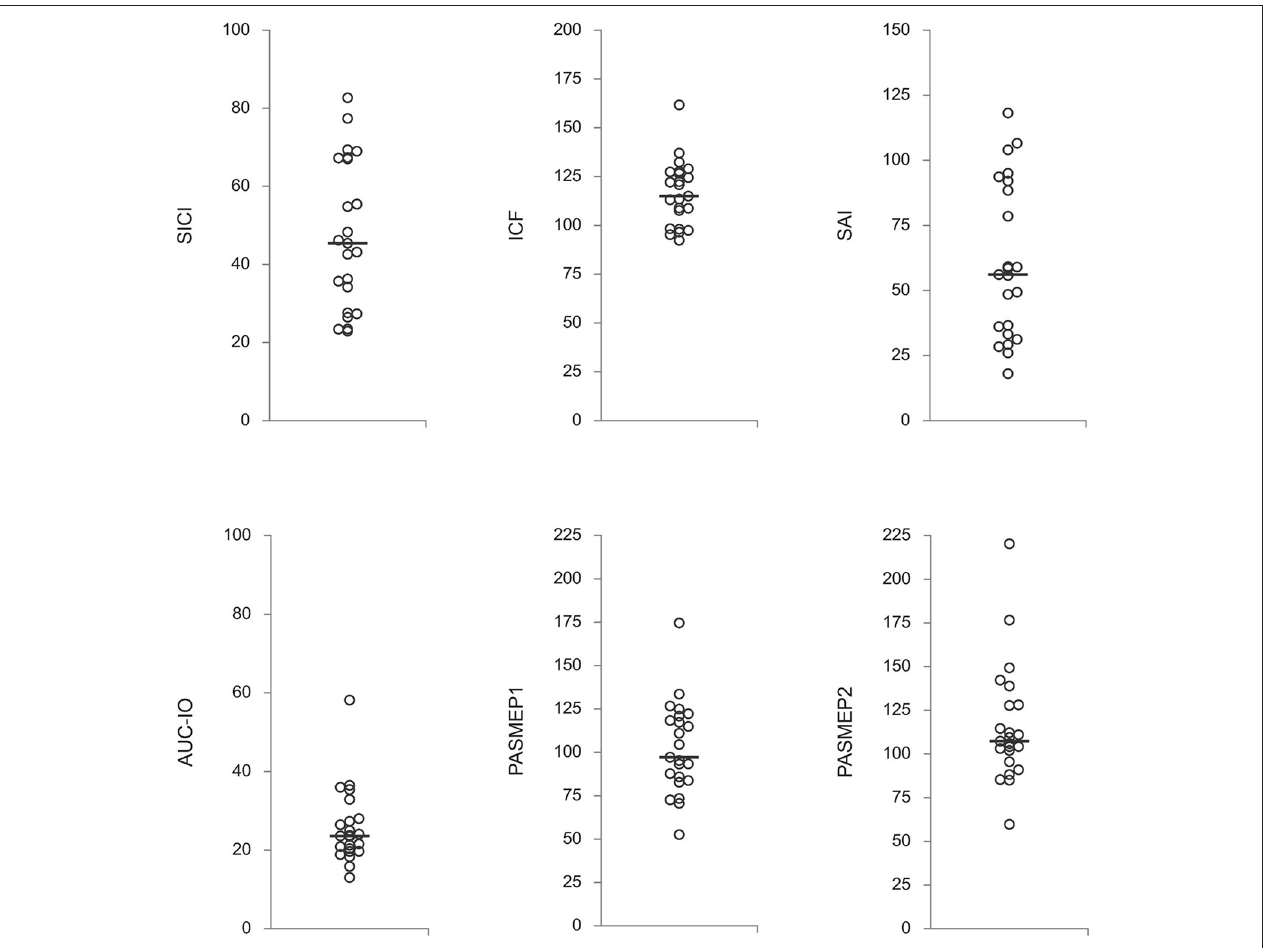
FIGURE 1 | Neurophysiological measures off-medication. Presented are individual subjects’ values with a median (horizontal line) for each measure. SICI, short-latency intracortical inhibition; ICF, intracortical facilitation; SAI, short-latency afferent inhibition; AUC-IO, area under the input-output curve; PASMEP1 and PASMEP2–motor evoked potentials (MEP) measured immediately and 30min after, respectively, paired associative stimulation protocol. SICI, ICF, and SAI are presented as ratios conditioned-MEP/test-MEP (in percentages). AUC-IO is presented as mVx%RMT (%RMT–resting threshold in percentages of the maximal stimulator output). PASMEP1 and PASMEP2 are presented as ratios post-PAS MEP/before-PAS MEP (in